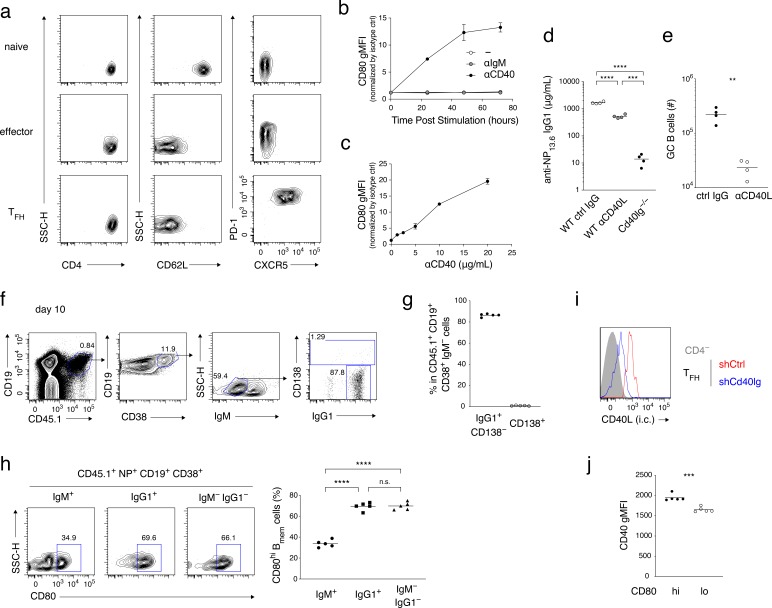
Supplementary data for Figure 2.(a) Naïve T (CD4+ CD62L+ CXCR5− PD-1−), effector T (CD4+ CD62L− CXCR5− PD-1dull), and TFH (CD4+ CD62L− CXCR5+ PD-1+) cells were sorted from spleen of mice immunized 10 days previously, for the experiments whose results are summarized in Figure 2a. The FCM profiles that are shown demonstrate the purity of the sorted fractions. (b) Naïve B cells were cultured with anti-CD40 Ab (10 μg/ml), anti-IgM Ab (10 μg/ml), or medium alone, for the indicated length of time, then stained with anti-CD80 antibody, and analyzed by FCM. gMFI of the CD80 staining was normalized to that of staining with isotype-matched control Ab. Mean ± s.d. of triplicates. (c) Naïve B cells were cultured with the indicated concentration of anti-CD40 Ab for 3 days, and analyzed as in (b). Mean ± s.d. of triplicates. (d) The concentration of anti-NP13.6 IgG1 Ab in the sera at 10 days after the immunization of the mice shown in Figure 2c,d and Figure 2b (Cd40lg−/− recipients) (n = 4). (e) Absolute number (#) of GC B cells (CD45.1+ NP+ CD19+ CD38−) in the spleens at 10 days after immunization of the mice shown in Figure 2c,d (n = 4). (f–h) Splenic B cells from CD45.1 B1-8 ki mice were transferred into B6 mice (CD45.2), which were then immunized with NP-CGG in alum. Splenocytes from the recipient mice at day 10 after immunization were analyzed by FCM. (f) Gating strategy for (g). (g) The frequency (%) of IgG1+ CD138− and CD138+ cells in CD45.1+ CD19+ CD38+ IgM− cells (n = 5). (h) Representative FCM data showing the expression of CD80 (left) and the frequency (%) of CD80hi cells (right; n = 5) in Bmem cells (CD45.1+ NP+ CD19+ CD38+) of the indicated isotype. (i) Knock-down efficiency of shCd40lg vector in TFH cells. Intracellular (i.c.) CD40L expression in shCtrl- or shCd40lg-transduced TFH cells and CD4− cells in the mice described in Figure 2g–i was analyzed by FCM. (j) CD40 expression on CD80hi and CD80lo Bmem cells (CD45.1+ NP+ CD19+ CD38+ IgM−) was analyzed by FCM at day 10 after immunization. gMFI of the CD40 staining is plotted (n = 5).